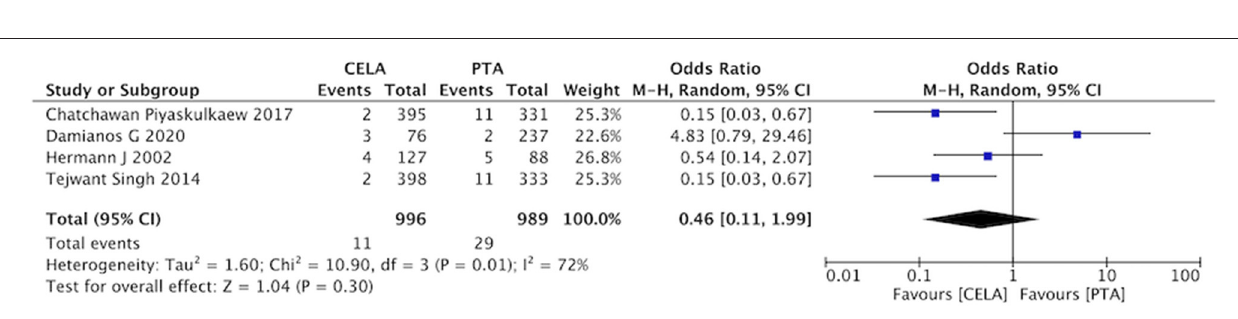
FIGURE 9 | Forest plot for dissection. Random, a randomized effects model; CI, confidence intervals. The blue squares stand for the weight of studies in meta-analysis. Black rhomboid represents the effects of combination of above five studies.